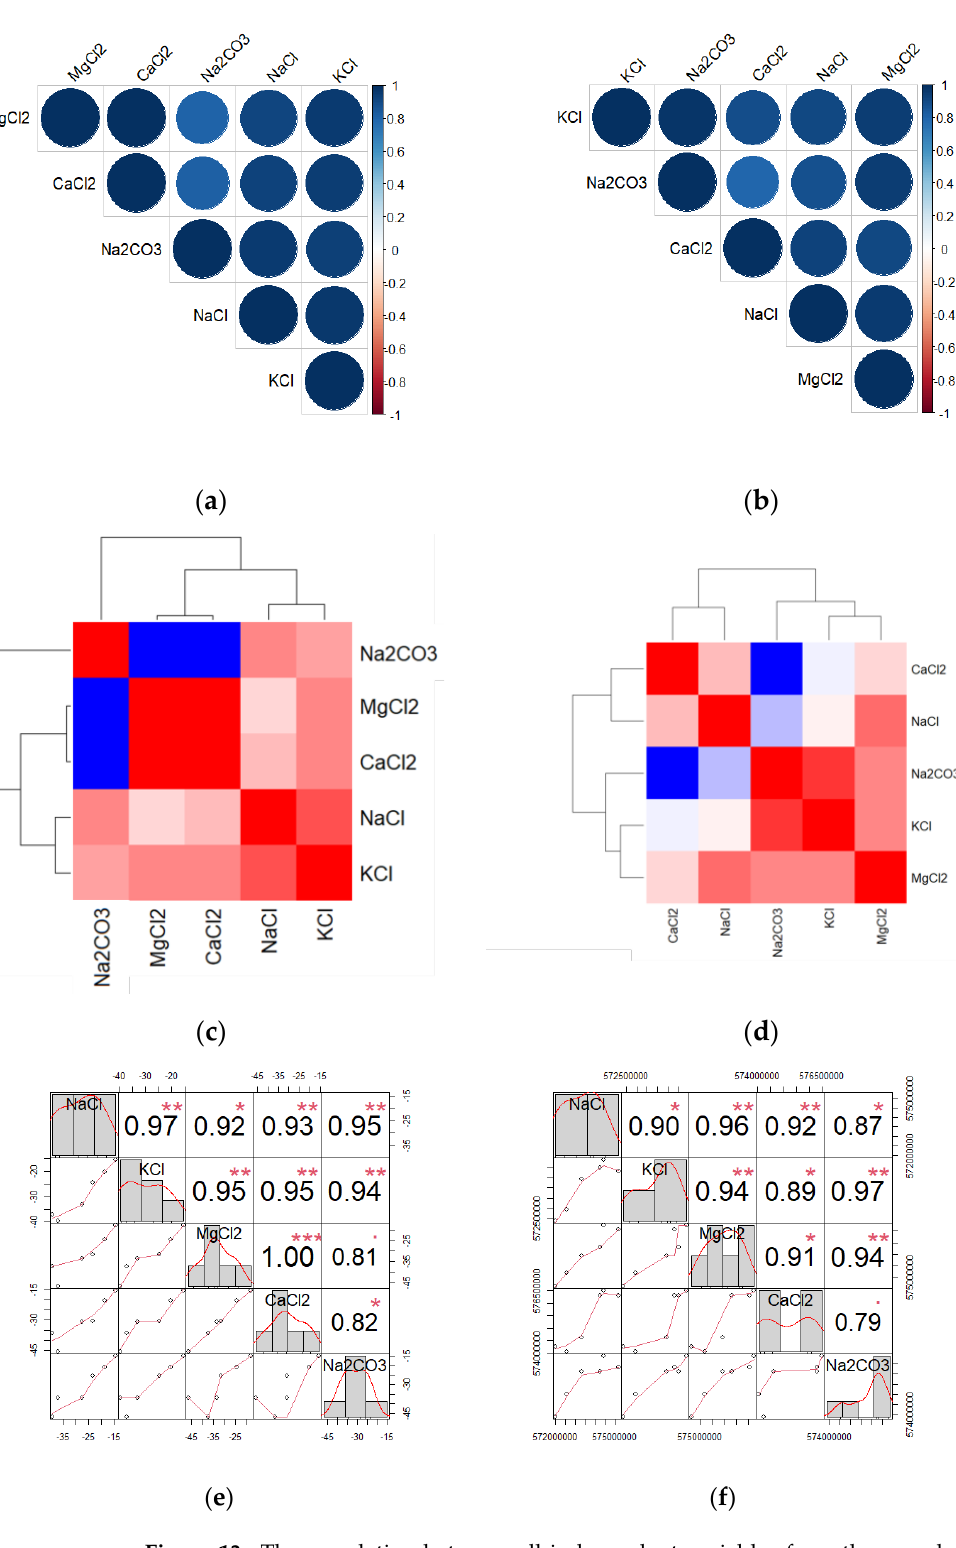
Figure 13. The correlation between all independent variables from the raw data obtained from the first resonance peak: ( a ) correlation plot (S 11 ), ( b ) correlation plot (F r ), ( c ) heatmap plot (S 11 ) (red color corresponds to the highest values), ( d ) heatmap plot (F r ) (red color corresponds to the highest values), ( e ) chart plot (S 11 ), and ( f ) chart plot (F r ). Each significance level is represented by a unique symbol, with the p-values 0.001 (***), 0.01 (**), and 0.05 (*).